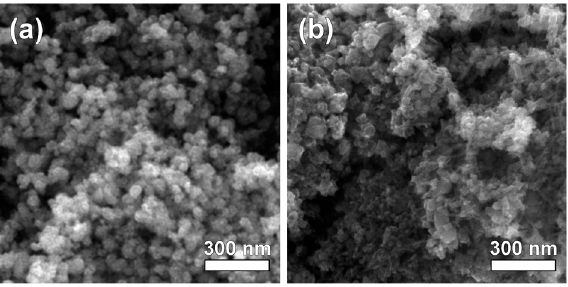
Figure 5. SEM images of original ( a ) and spent ( b ) adsorbent.